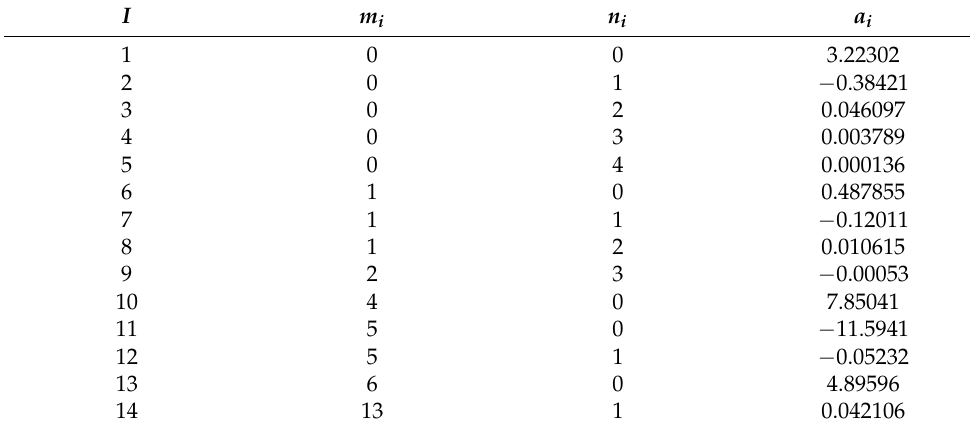
The relationship between the compositions of the gas phase, indicated as a mole fraction in the vapor phase y vap p , x considering pressure p and mole fraction of NH 3 in the liquid phase X , can be described by Equation (A41). The coefficients for Equation (A41) are presented in Table A9, while p 0 is 2 MPa.